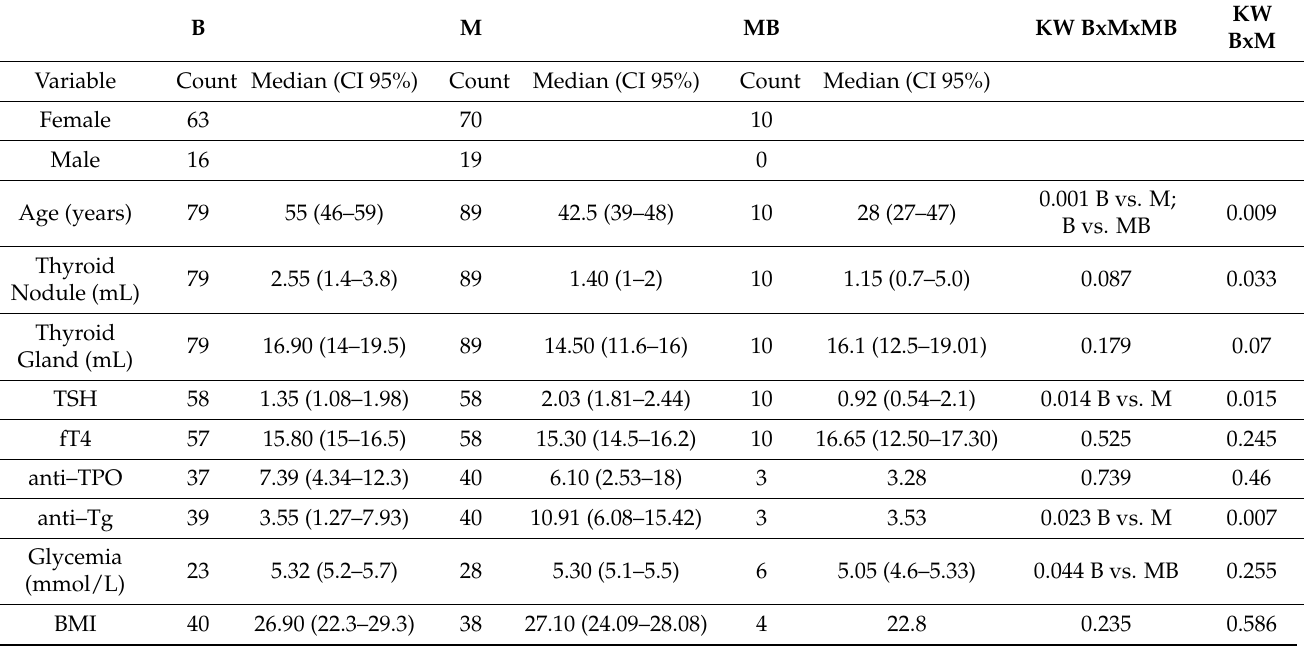
Table 1. Comparison of clinical, biochemical, and imaging characteristics between B (benign), M (malignant), and MB (borderline tumor) cohorts of patients with Kruskal–Wallis one-way ANOVA on ranks